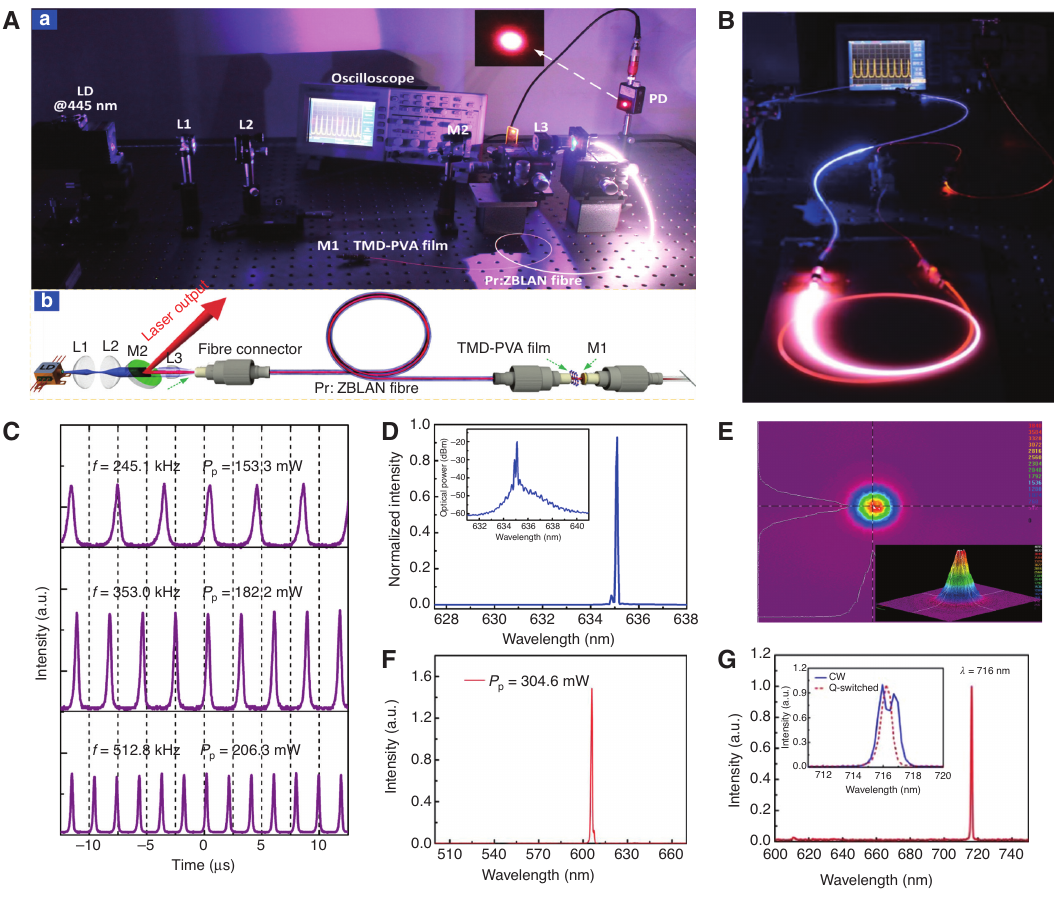
Figure 8: Q-switched fiber lasers based on nanomaterial SAs in the visible spectral range. (A) Photograph and schematic of the red Q-switched fiber laser with WS . (B) Photograph of TMD-based orange Q-switched fiber laser. 2 (C) Pulse trains of the red Q-switched fiber laser under different pump powers. (D) Optical spectrum of the red Q-switched fiber laser (inset: with a dBm logarithmic scale). (E) Red laser mode-field distribution. (F) Optical spectrum of the orange Q-switched fiber laser. (G) Optical spectrum of deep-red Q-switched fiber laser with CNTs SA; inset: a close look of CW and Q-switched laser spectra. (A) and (C–E) Reprinted from Ref. [157], Copyright 2016, The Royal Society of Chemistry. (B) and (F) Adapted from Ref. [170], Copyright 2016, Optical Society of America. (G) Reprinted from Ref. [165], Copyright 2017, Optical Society of